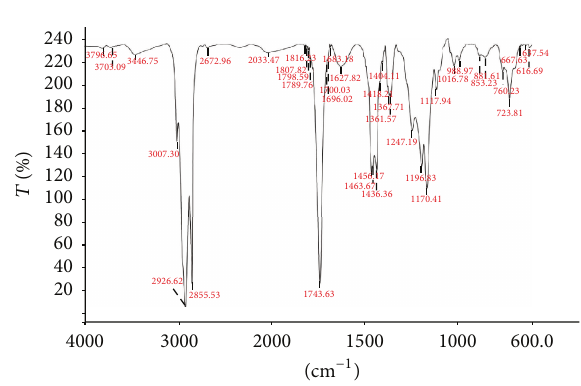
Figure 2: FT-IR spectra of Pongamia pinnata biodiesel.